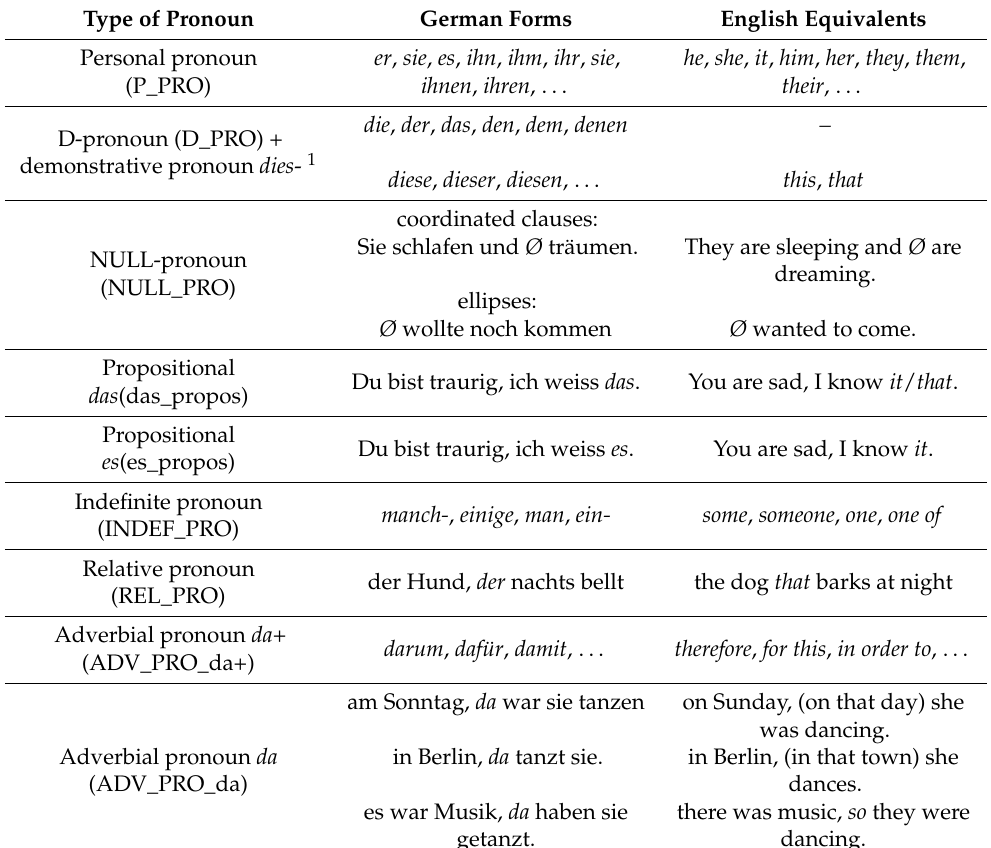
Table 2. Types of pronouns included in the proportional analysis of types of